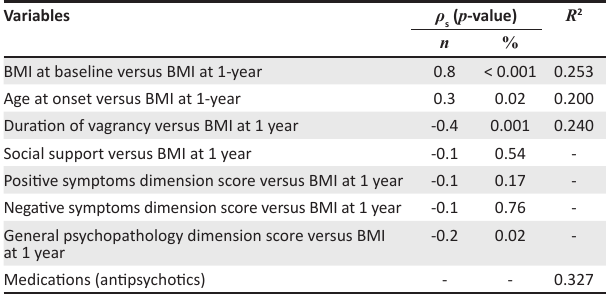
TABLE 4: Relationship between body mass index at 1 year and body mass index at baseline, duration of vagrancy, age at onset, social support and disease